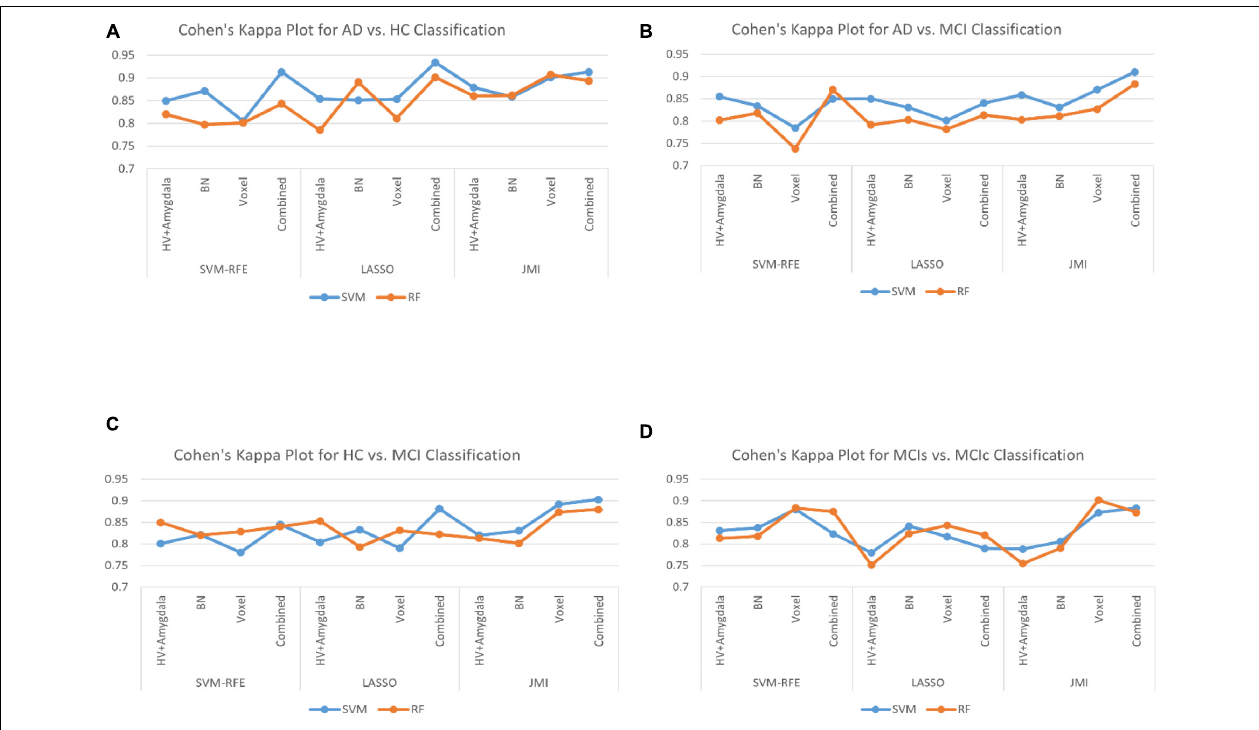
FIGURE 10 | The Cohen’s Kappa index for (A) AD vs. HC group, (B) AD vs. MCI group, (C) HC vs. MCI group, and (D) MCIs vs. MCIc group for individual and combined feature set and different feature selection algorithm. TABLE 2 | A 10-fold cross-validated binary classification performance for Alzheimer’s disease (AD) vs. healthy control (HC) groups using support vector machine (SVM) and Random Forest (RF) classifiers. Performance Matrix SVM